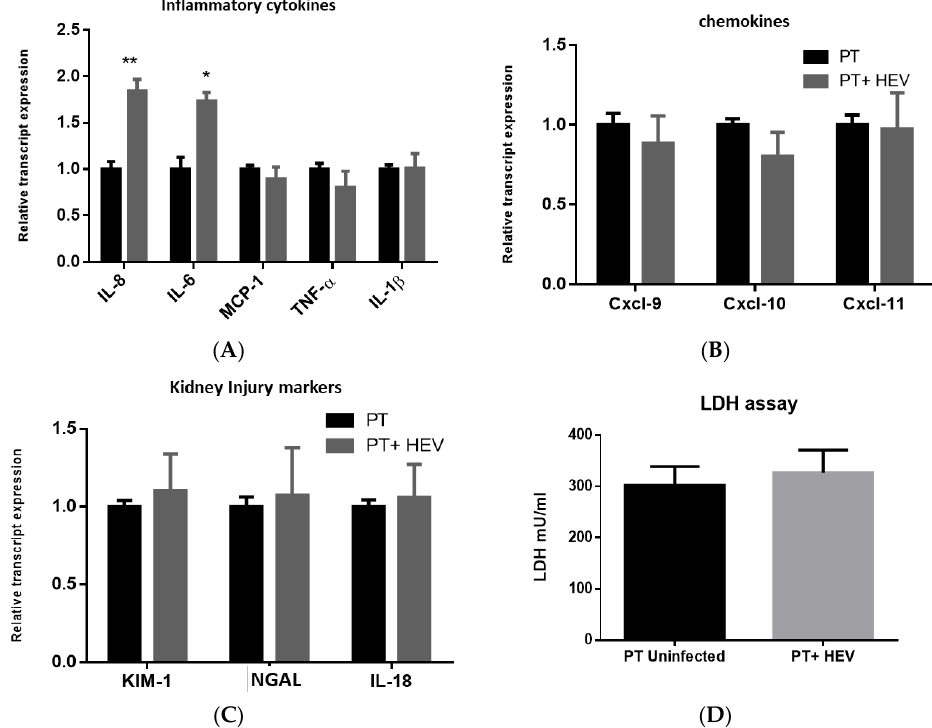
Figure 3. HEV infection alone did not affect the transcription of chemokines nor kidney injury markers of the PT epithelium. CD10+/CD13+ PT cells were challenged with HEV-1 for 10 days and then total cellular RNA was extracted and the mRNA expression level of proinflammatory markers (IL-8, IL-6, MCP-1, TNF-α, and IL-1β) ( A ), chemokines (Cxcl-9, Cxcl-10, and Cxcl-11) ( B ), and kidney injury transcripts (kidney injury molecule 1 (KIM-1), neutrophil gelatinase-associated lipocalin (NGAL), and interleukin 18 (lL-18)) ( C ) were assessed. The relative gene expression was determined by comparing the expression levels of these transcripts with mock cells. Black columns represent uninfected cells, and grey columns represent HEV infected cells. Data represent the mean +/− SEM of four separate experiments. *, **, indicates p ≤ 0.05 and p ≤ 0.01 as assayed by two-tailed Student’s t - test. ( D ) The level of LDH was measured in the supernatants of PT infected or not with HEV at Day 10 postinfection. Data represent the mean ± SEM of four separate experiments. Black columns represent uninfected cells, and grey columns represent HEV infected cells.